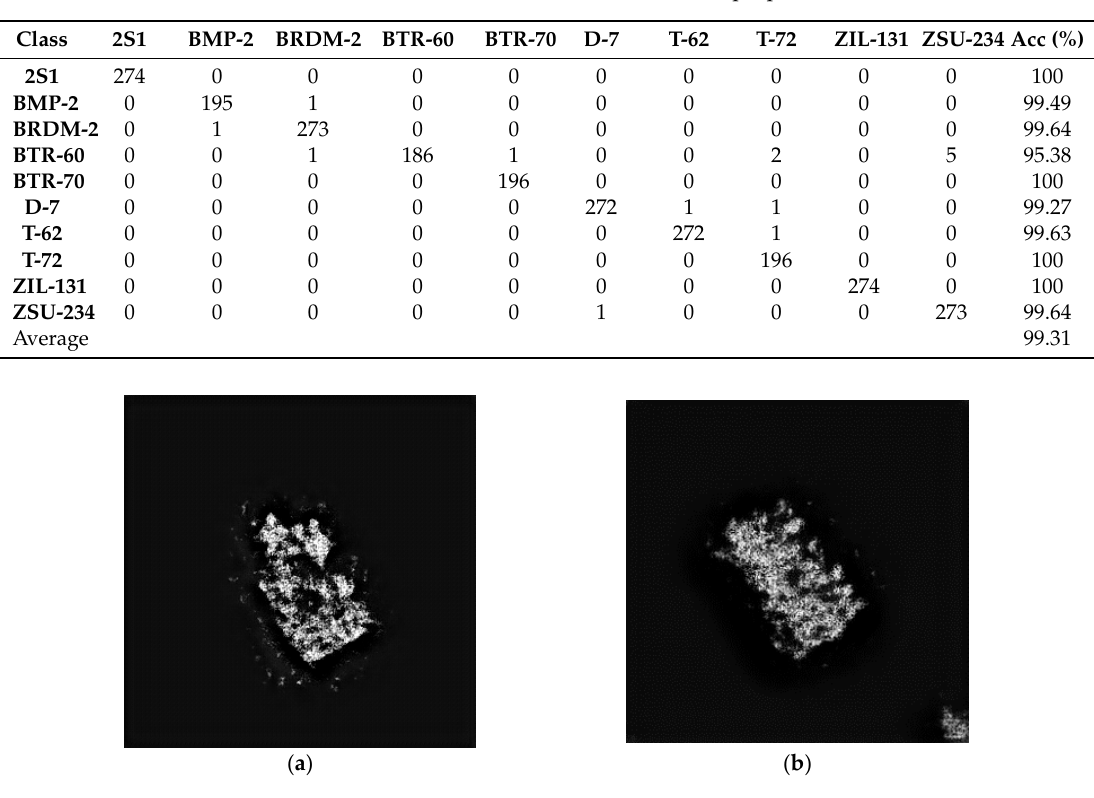
Figure 13. Image of ( a ) BTR-60 and ( b ) ZSU-234 in test set. Table 2. The confusion matrix under SOC based on the proposed method.